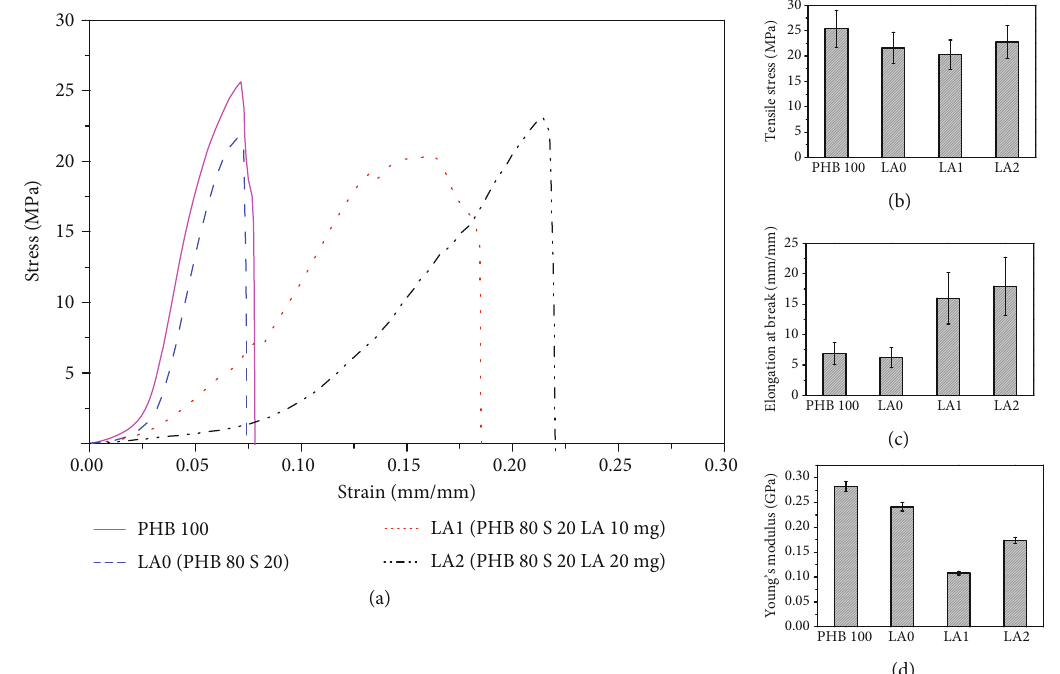
Figure 7: UTM results of PHB/S/LA composites. (a) Stress – strain graph. (b) Tensile strength. (c) Elongation at break. (d) Young ’ s